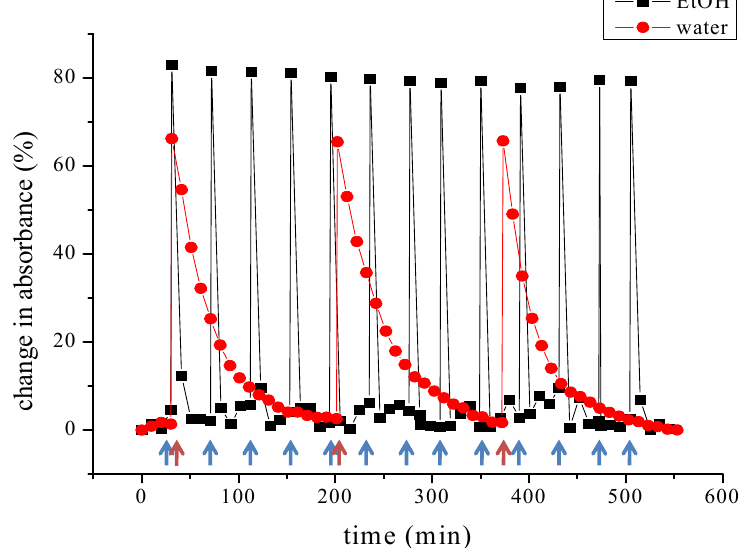
Figure 4. Reversible interconversion between the spiropyran and the open merocyanine form: The thermal-induced back-reaction from the SP form to the MC form of spiropyran- DO3A-Gd in water and ethanol solution was determined after illumination at a temperature of 37 °C. Blue arrows represent the irradiation time points of the water solution, while red arrows represent illumination of spiropyran-DO3A-Gd in